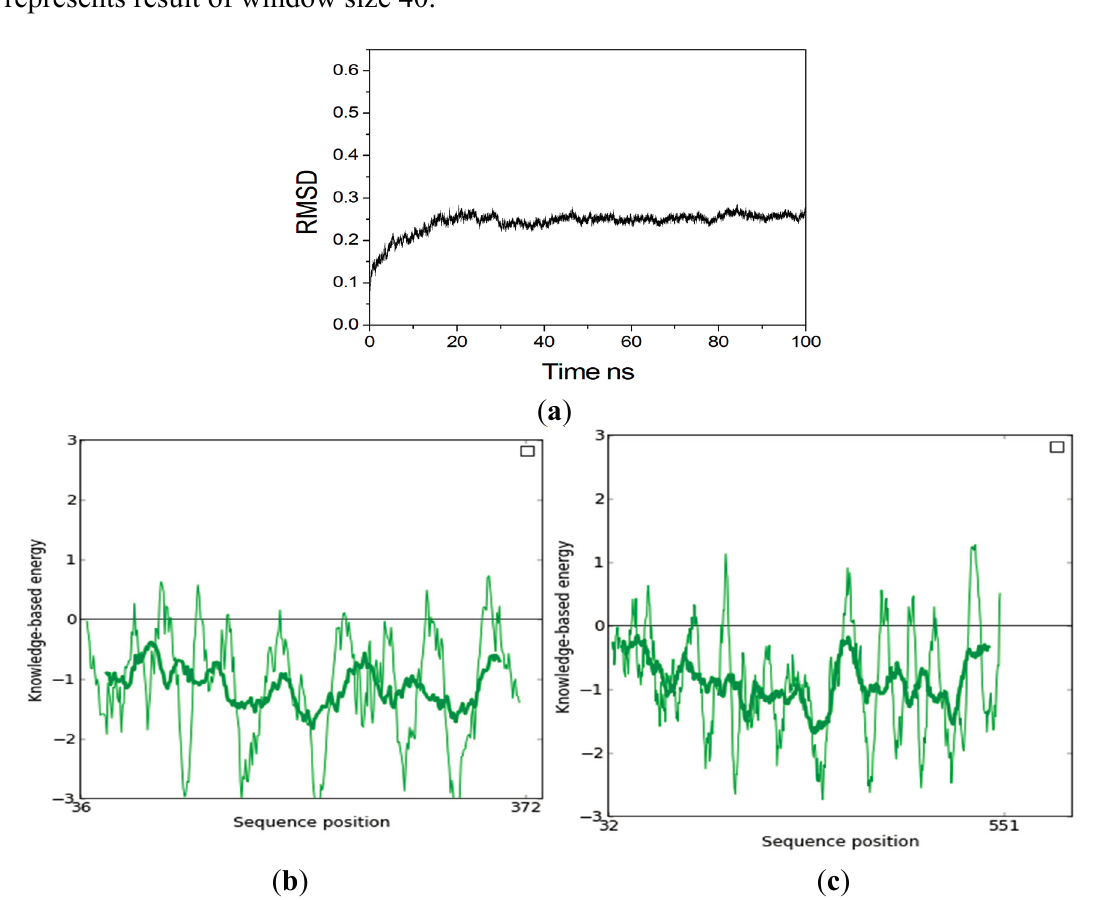
Figure 3. ( a ) The C α RMSD during the 100 ns MD. Screen shot of residue of a native protein ( b ) Xyn10A; ( c ) Xyn10b. Thin line represents result of window size 10, thick line represents result of window size 40.